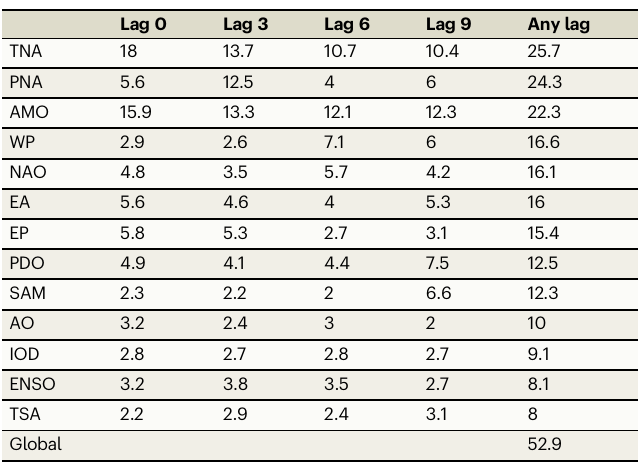
Table 1 | Climate teleconnections (CTs) modulate 52.9% of the global burned area (BA) Lag